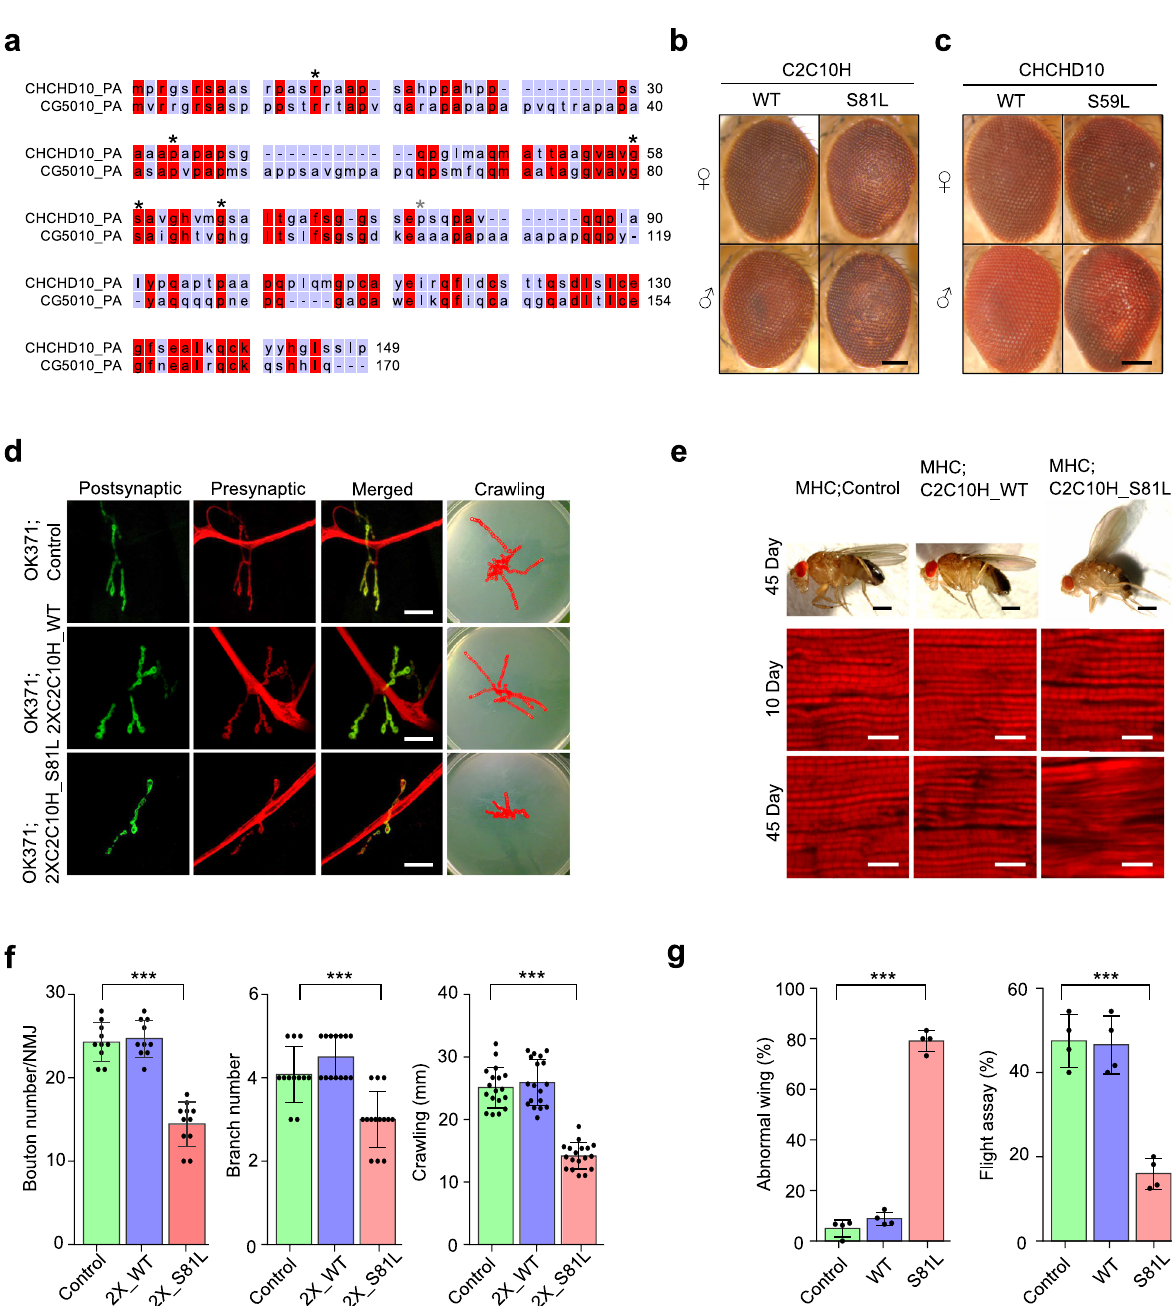
Fig. 1 C2C10H S81L is toxic in Drosophila eyes, neurons, and muscles. a Protein sequence alignment of human CHCHD10 and Drosophila C2C10H (CG5010). Disease-causing sites (asterisk) are conserved between human CHCHD10 and Drosophila C2C10H. b C2C10H S81L (representative images from two independent experiments) and c human CHCHD10 S59L cause age-dependent mild rough eye phenotypes in 40-day-old fl ies (representative images from two independent experiments). Scale bar = 200 μ m. d Representative images of neuromuscular junctions and crawling traces from the genotypes indicated (see below for statistical analysis). Scale bar = 20 μ m. e Adult thoraxes dissected to expose longitudinal indirect fl ight muscles and stained with phalloidin – Alexa Fluor 594. Flies expressing C2C10H S81L in muscles under control of MHC -GAL4 exhibit disrupted sarcomere structures. Scale bar = 0.5 mm ( fl y) and 10 μ m (muscle). f Expression of C2C10H S81L in motor neurons results in small synapses, with reduced bouton and branch numbers and defective locomotive activity assessed by the crawling behavior of third-instar larvae. Data are mean ± SD (one-way ANOVA and post hoc Dunnett test, two-sided, *** p = 5.3e − 10, 0.0002 and 3.8e − 14 for bouton number ( n = 10 – 11), branch number ( n = 12 – 14), and crawling distance ( n = 18) from three independent experiments, respectively). g Expression of C2C10H S81L in muscle tissues causes abnormal wing postures and locomotor defects assessed by fl ight ability. Data are mean ± SD (one-way ANOVA and post hoc Dunnett test, two-sided, *** p = 4.3e − 10, 5.5e − 05 for abnormal wing posture, fl ight assay, respectively; n = 4 with >40 fl